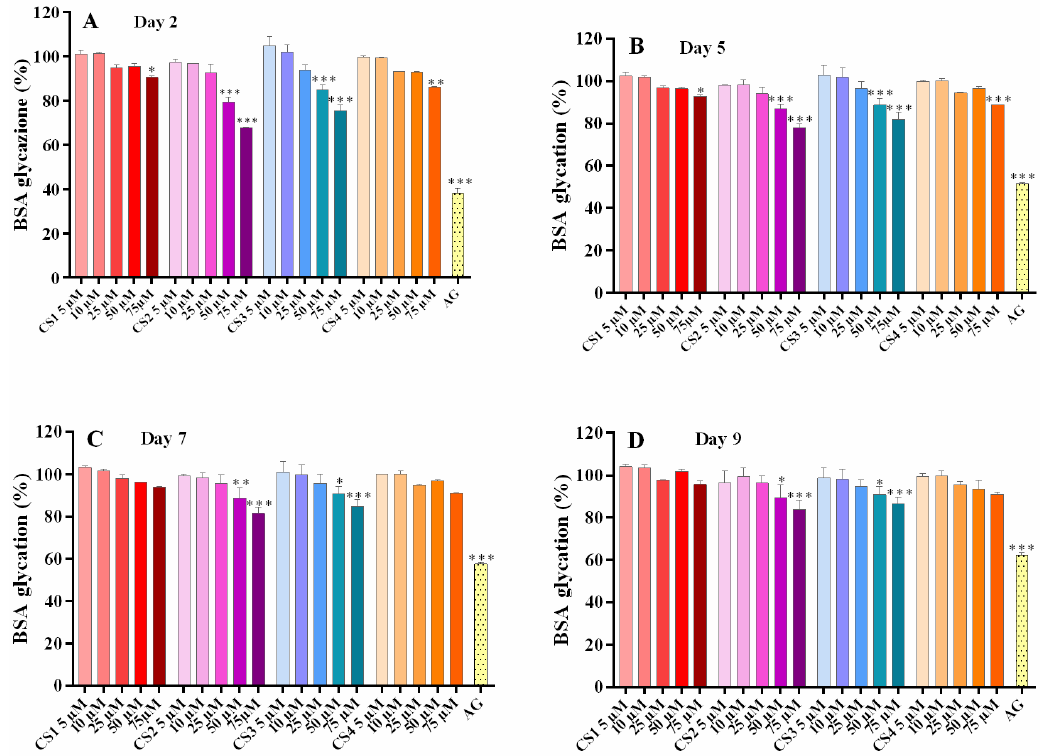
Figure 3. Inhibition of synthetic compounds CS1–CS4 on AGE production after 2 ( A ), 5 ( B ), 7 ( C ), and 9 ( D ) days of incubation of 50 mg/mL BSA with 0.1 M ribose. Aminoguanidine (50 mM, AG) was the positive control. Data are the mean ± SEM of 3–6 experiments. * p < 0.05, ** p < 0.01, *** p < 0.001 vs. maximal ribose-induced BSA glycation (controls).